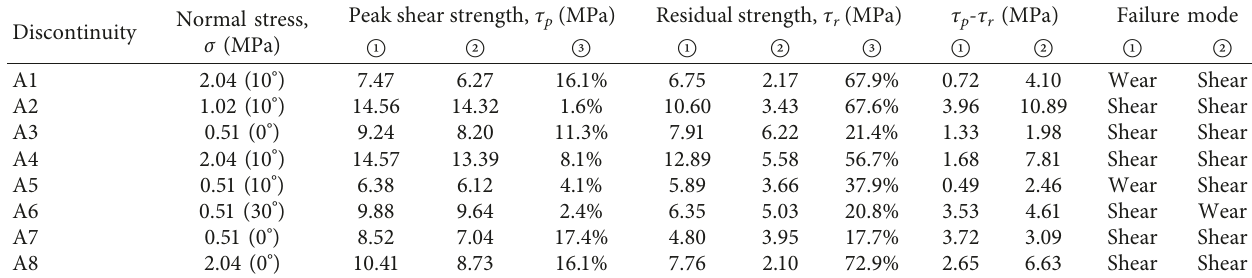
Table 2: Comparison of failure modes and shear strengths between the original samples and subsamples. Normal Discontinuity